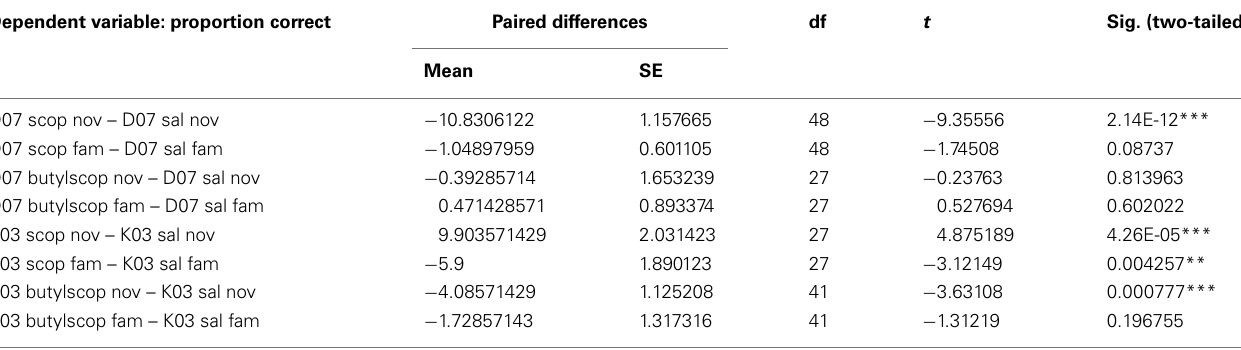
Table 1 | Paired t -tests of categorization performance of drug treatment (scopolamine or butyl-scopolamine) vs. saline (paired experiments were conducted on alternate